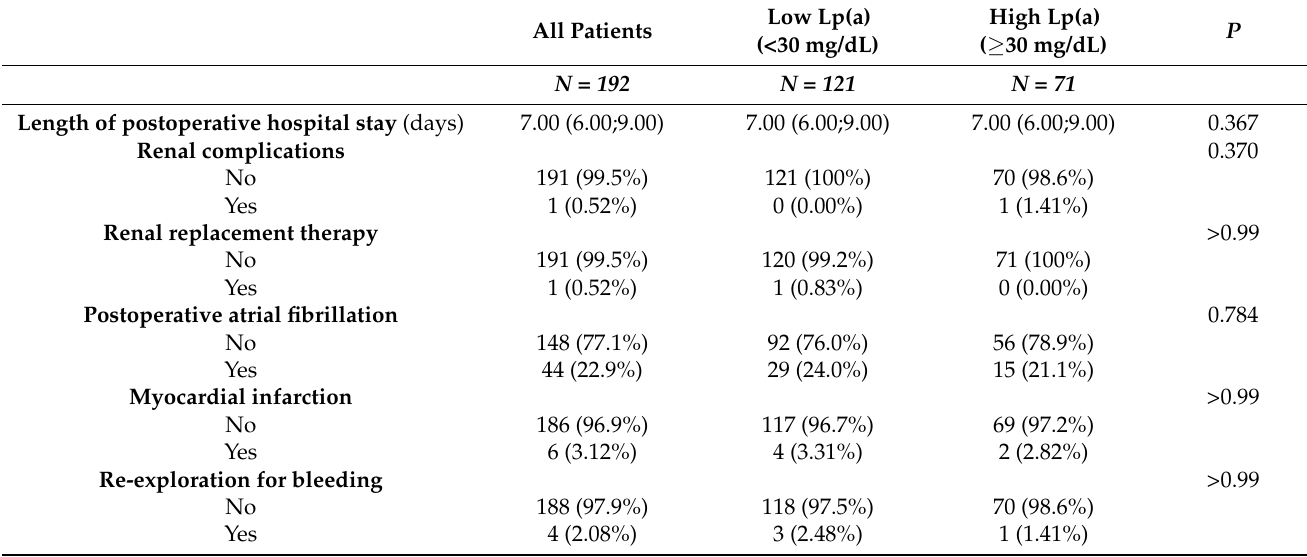
Table 3. Secondary